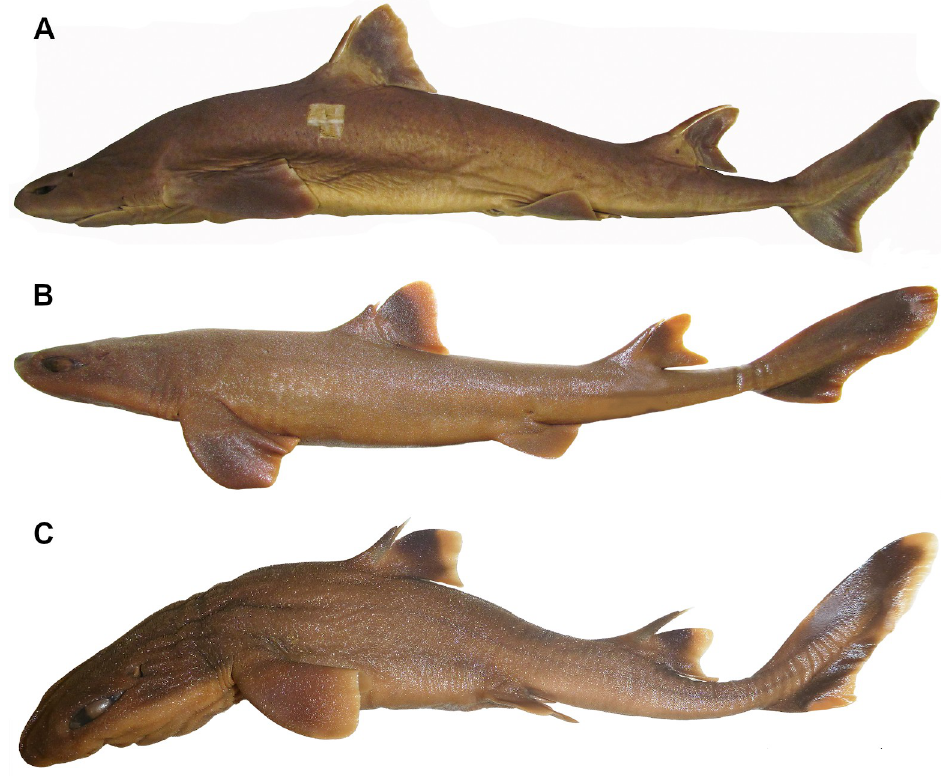
Fig 25. Clasper (right side) of the paratype of C . asper , BMNH 1972.10.10.2, adult male, 847 mm TL in dorsal view. Abbreviations: ap: apopyle; cg: clasper groove; hp: hypopyle; p2: pelvic fin; rh: rhipidion. over vertical traced at free rear tips of pelvic fins. Second dorsal fin with anterior margin con- vex and large, its length 13.9% (7.8%–14.5%) TL; second dorsal-fin posterior margin markedly falcate and elongate, its length 6.9% (3.9%–8.0%) TL; second dorsal-fin apex conspicuously slender and lobe-like, and free rear tip pointed. Second dorsal-fin spine thick (its base width 1.0%, 0.8%–1.2% TL), and elongate, its length 7.3% (3.4%–7.6%) TL and not reaching second dorsal-fin apex with its length 0.9 (0.4–1.4) times height of second dorsal fin; second dorsal-fin spine slightly larger than first one (its length 1.3, 0.6–2.2 times length of first dorsal spine). Pectoral fin conspicuously wide distally and square-like (Fig 24A); pectoral-fin anterior margin convex and elongate, its length 1.7 (1.2–1.9) times larger than pectoral-fin inner mar- gin length, and corresponding at least to one-half the distance between pectoral and pelvic fins; pectoral-fin inner margin markedly convex; pectoral-fin posterior margin straight and large, its length 10.5% (8.7%–12.9%) TL; apex and free rear tip of pectoral fins conspicuously rounded and broad, not lobe-like and almost reaching the same length. Pectoral-pelvic dis- tance 1.1 (0.7–1.5) times pelvic-caudal space; the latter 1.0 (0.8–1.3) times interdorsal space. Pelvic fins in the midline between first and second dorsal fin, although nearest to second dorsal fin in some paratypes and non-type specimens. Pelvic fins markedly broad with anterior mar- gin somewhat convex (Fig 24B), posterior margin straight; pelvic-fin apex rounded and con- spicuously wide, and free rear tips rounded and lobulated, although more slender in males. Claspers in adults slender and flattened ventrally (Fig 25); claspers very short its inner length 1.1, (0.4–1.2) times pelvic inner margin length, transcending pelvic free rear tips; clasper groove very large, vertical, placed dorsally; apopyle and hypopyle with narrow apertures,